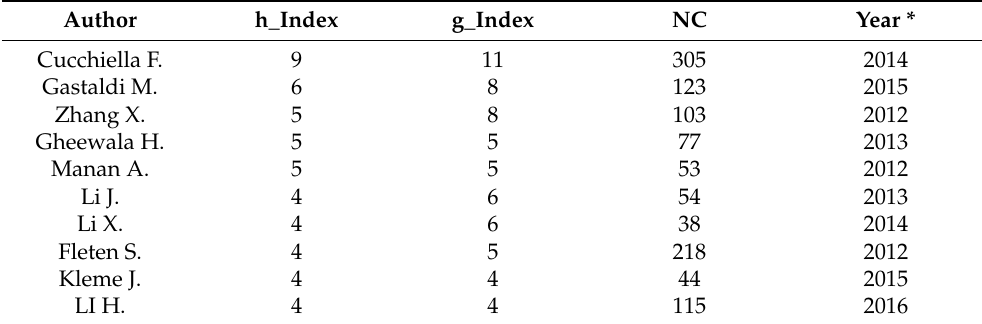
Table 3. Authors Impact (TPEM).